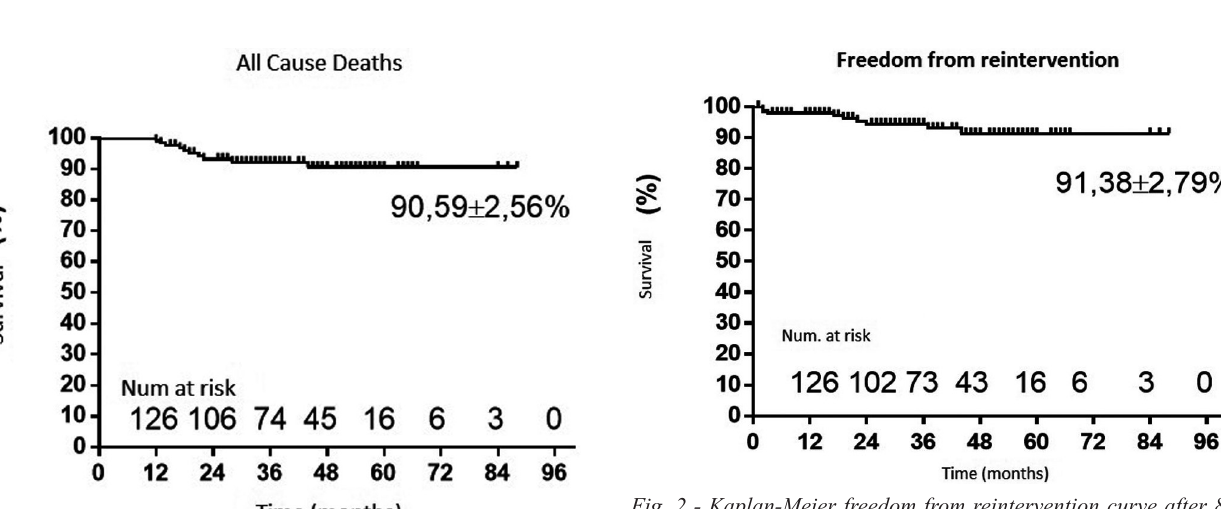
Fig. 2 - Kaplan-Meier freedom from reintervention curve after 88 months of aortic valve prosthetic implantation.